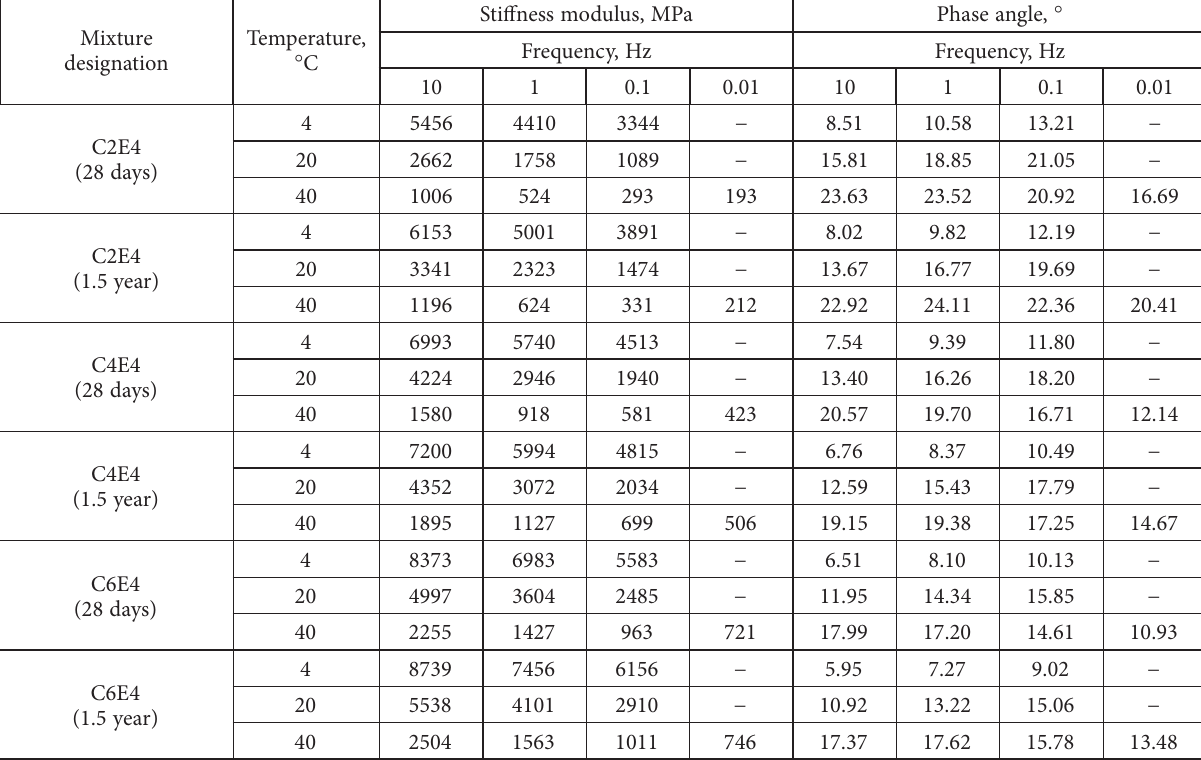
Table 3. Stiffness modulus moduli and phase angles for selected Mineral-Cement-Emulsion mixtures Mixture